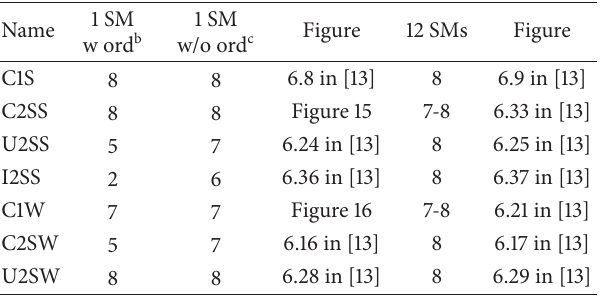
Figure 11: Measurement I2SS. Two intermediate correlated strong transmitters. (a) Capon DOA spectrum. (b) Eigenspectrum. Zoom-in to the right. dB scale. See Section 3.3 for “SM.” Table 3: Summary of eigenpattern results a